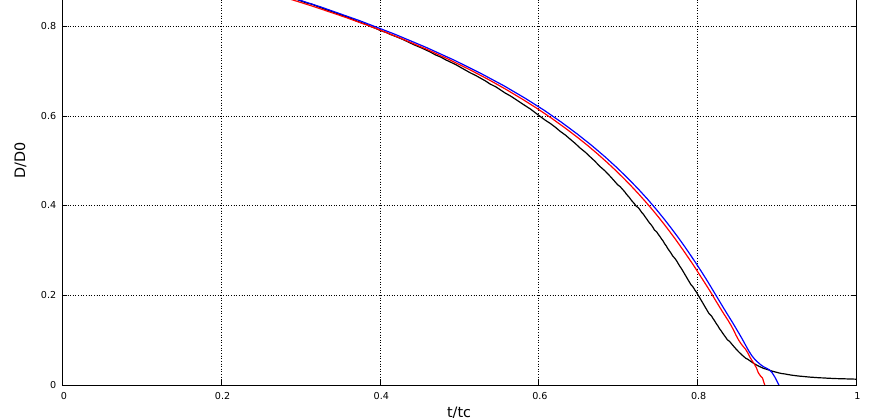
Figure 8. The necking instability over time.